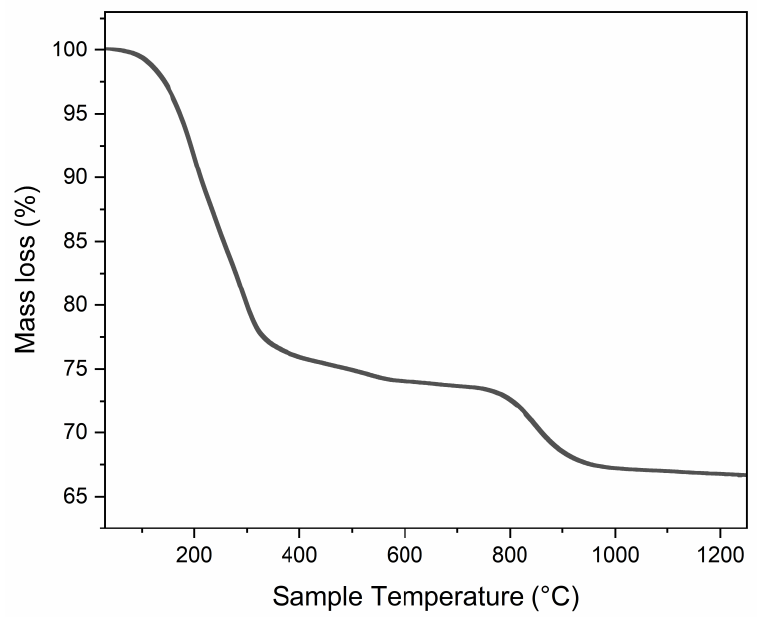
Figure 1. TGA curve for the ZnAl-SO 4 LDH from [7].